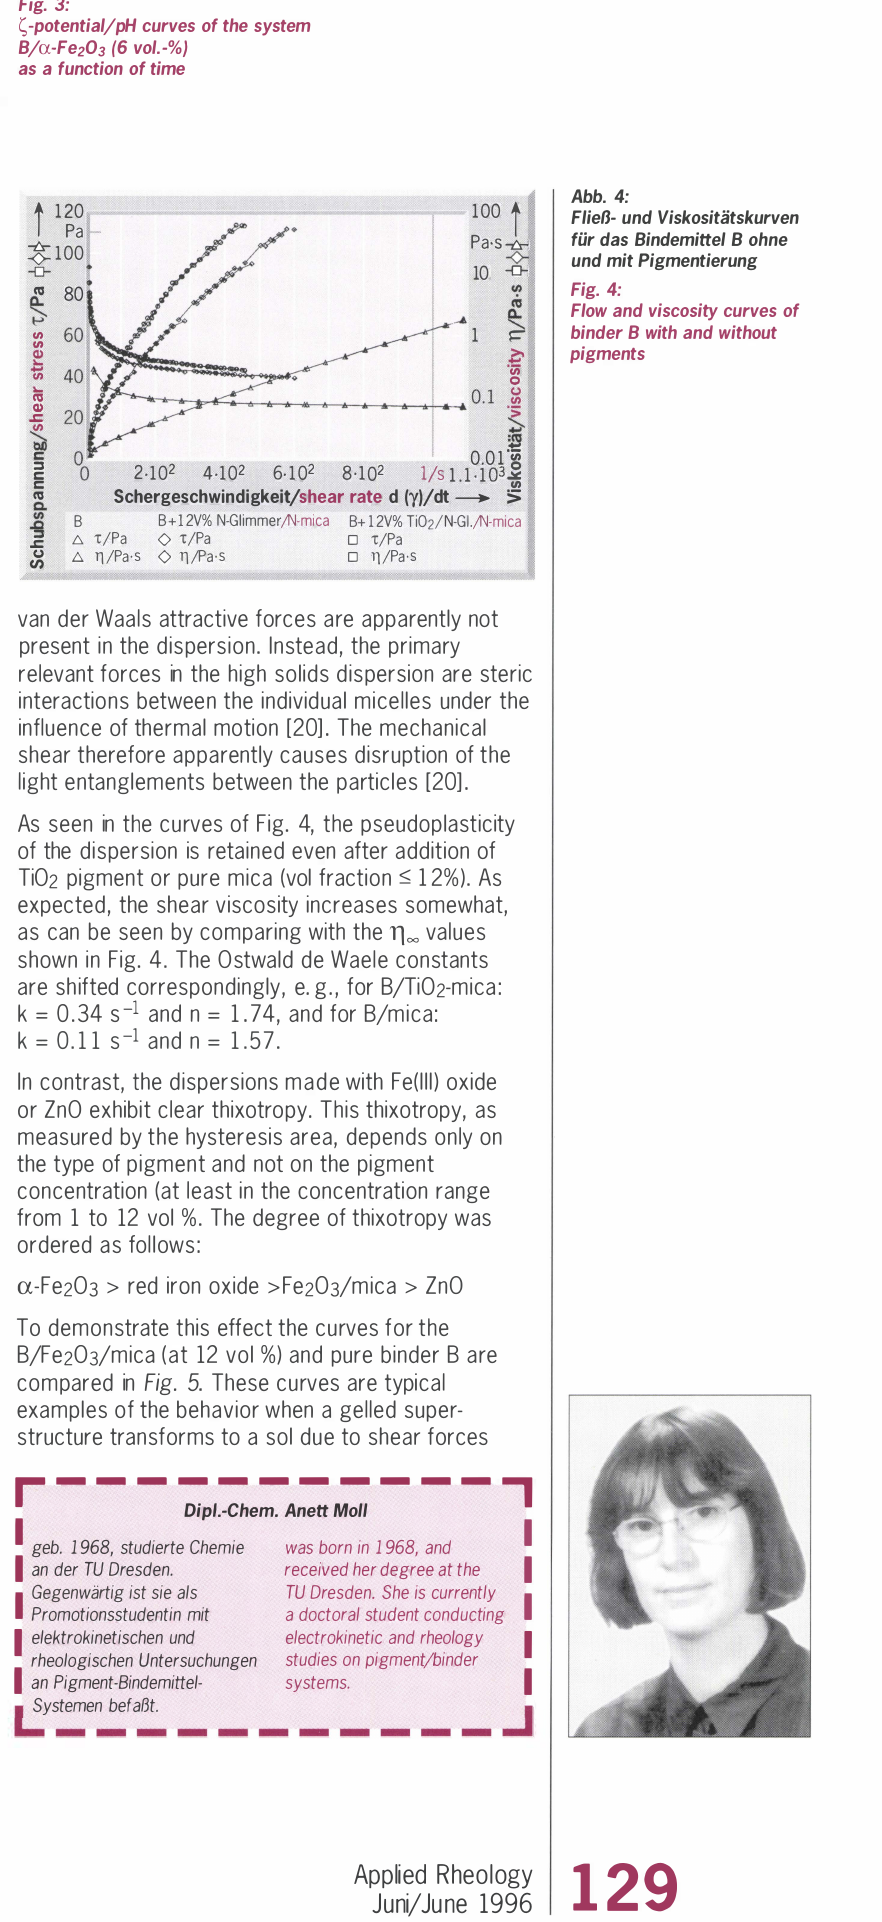
Fig. 3: s -potential/pH curves of the system